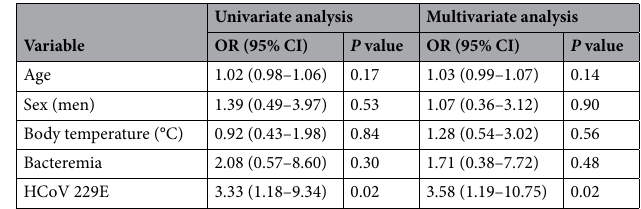
Table 2. Factors associated with 30-day all-cause mortality among patients with human coronavirus 229E and OC43 infections.